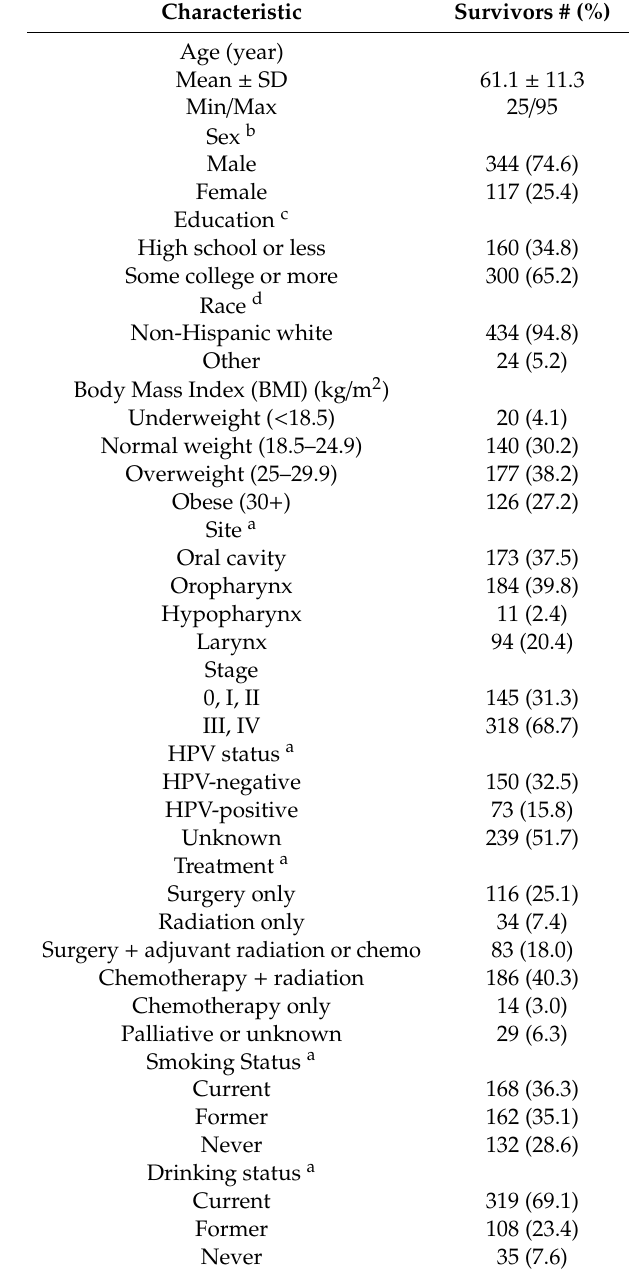
Table 1. Demographic, clinical, and behavioral characteristics of the study participants ( n =